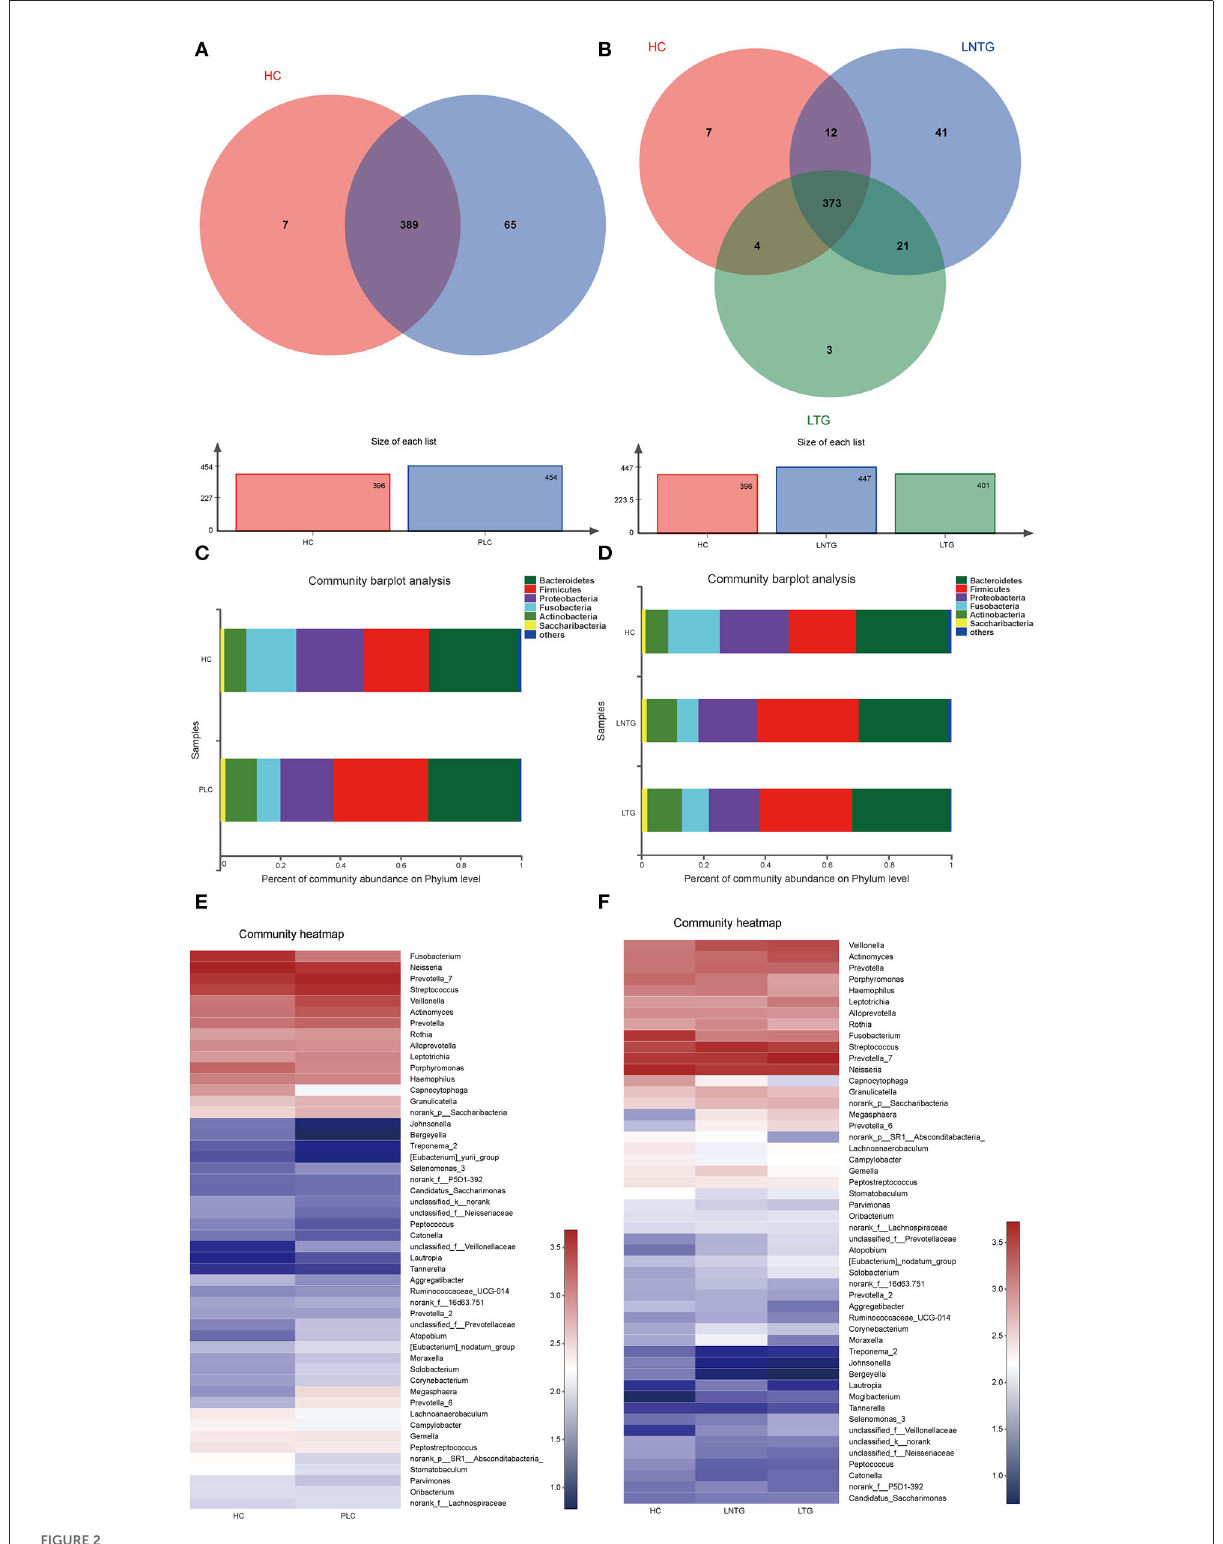
FIGURE2 The tongue-coating microbial dysbiosis. (A) Venn diagram of the shared OTUs between HC and PLC groups in tongue-coating contents. (B) Venn diagram of the shared OTUs among HC, LTG, and LNTG groups in tongue-coating contents. (C,D) The relative abundance of tongue-coating microbiota at the phylum level in the two different groups (C) and the three different groups (D) . (E,F) The heatmap of the